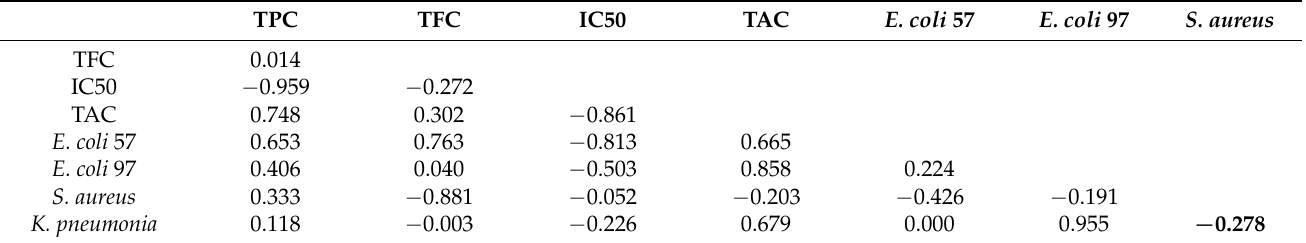
Table 5. Pearson correlation coefficients between different parameters of Papaver rhoeas .